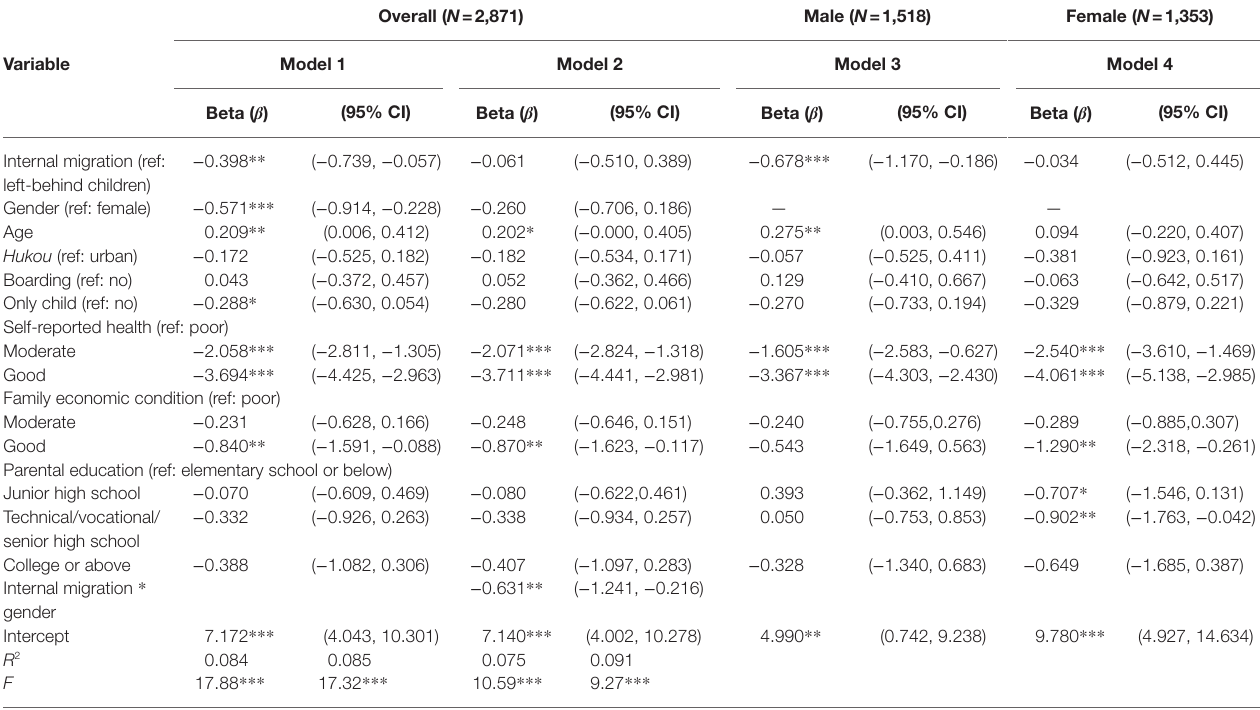
TABLE 4 | Multivariate linear regression analysis of the association between internal migration and depression among Chinese junior high school